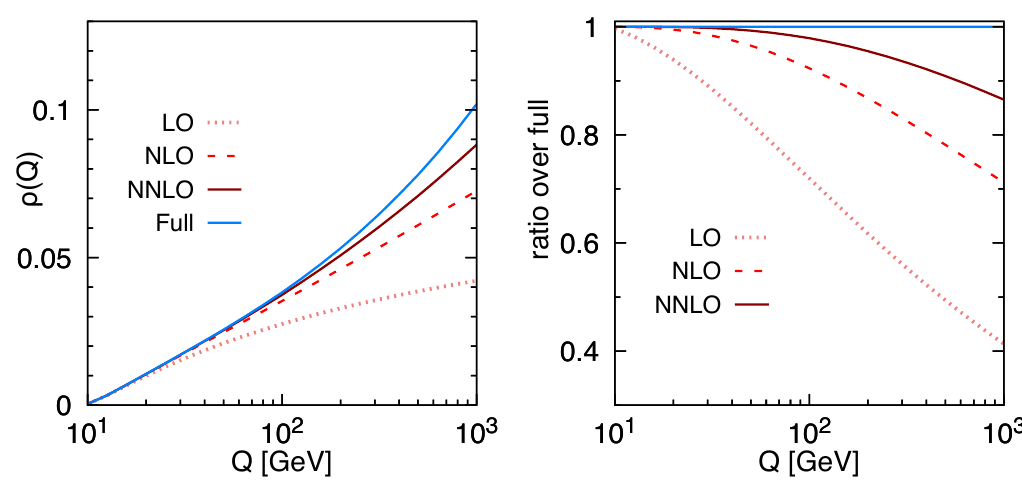
Figure 8 . The heavy quark multiplicity computed by truncating eq. (6.1) up to di(cid:11)erent orders of (cid:11) s ( Q 2 ), compared with the full result. The right panel show the ratio over the full result.